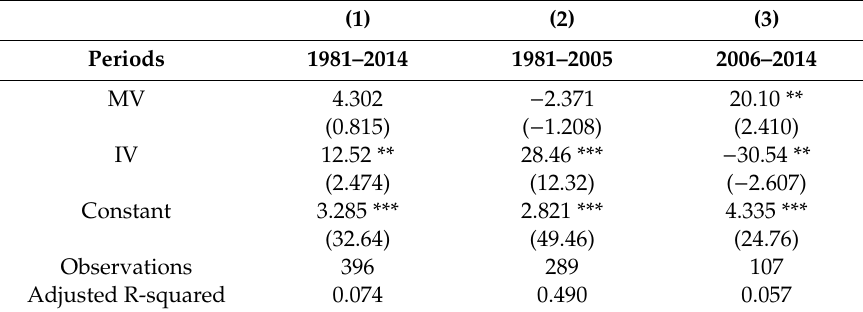
Table 4. Regression results of dispersion on MV and